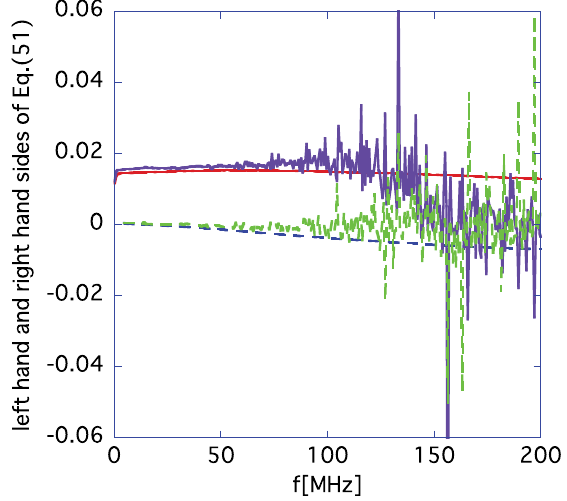
FIG. 17. Comparison between the left- (purple/green) and right-hand (red/blue) sides of Eq. (51) for the ceramic break in the lower figures of Fig. 4.